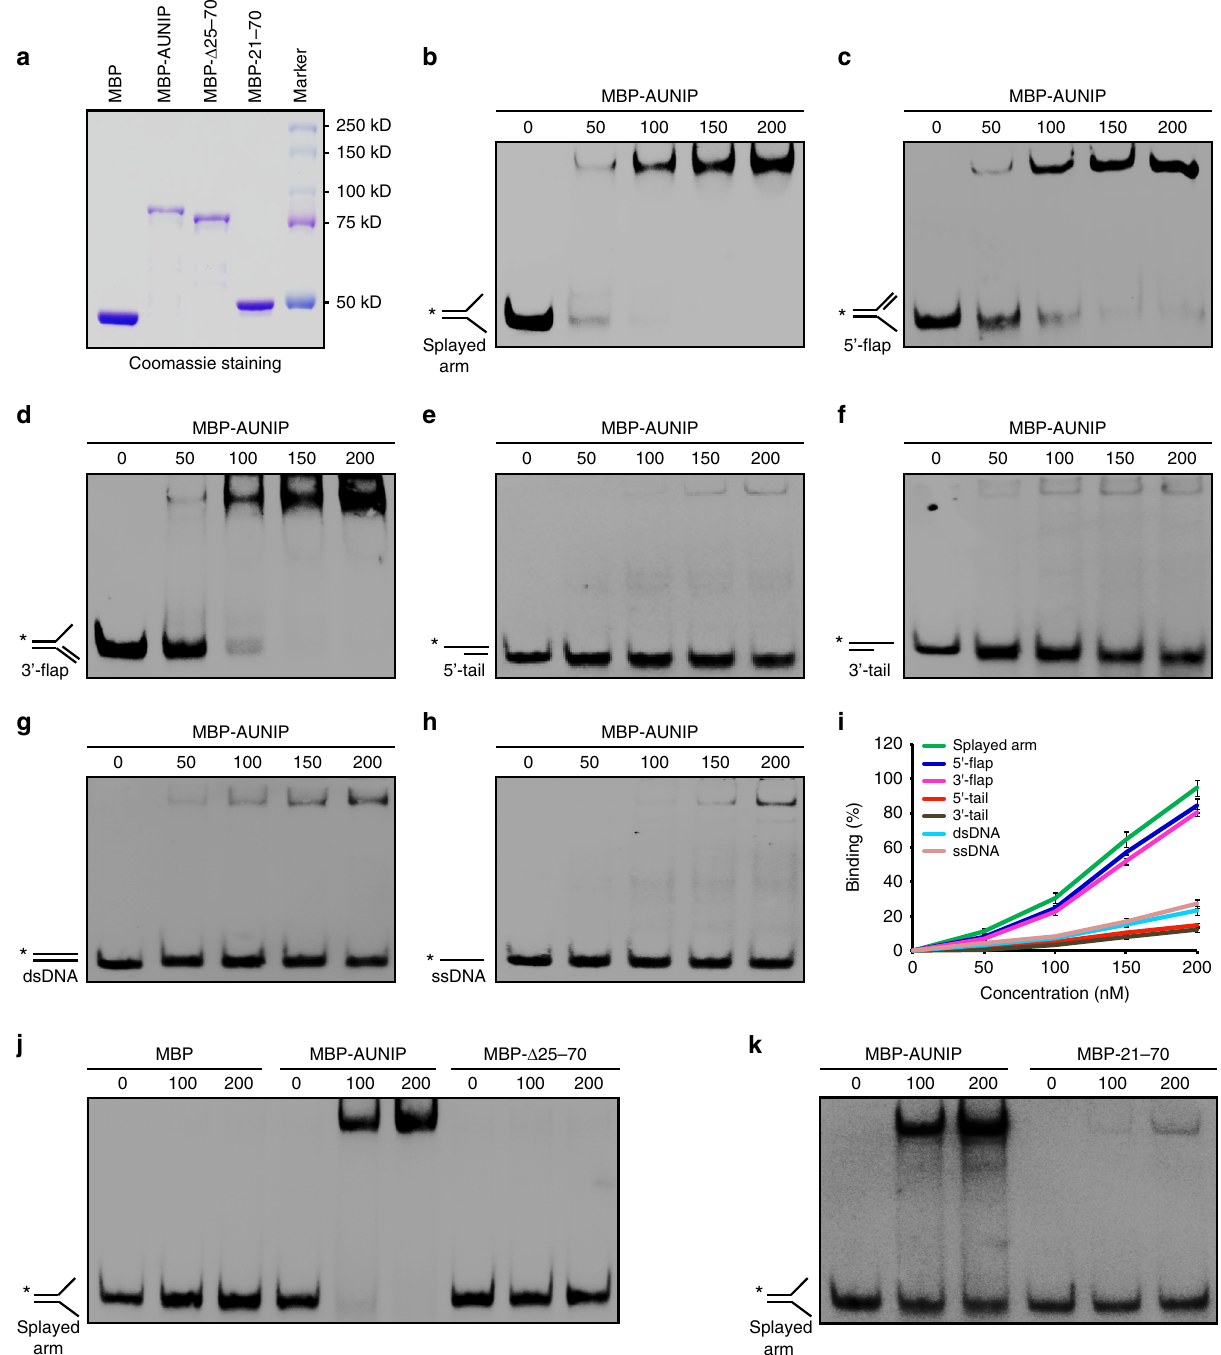
Fig. 6 DNA-binding activity of AUNIP. a SDS-PAGE pro fi le of puri fi ed MBP-tagged wild-type and mutants of AUNIP. b – h DNA-binding activity of AUNIP. Biotin-labeled DNA substrates (20 nM each) were incubated with increasing amounts of puri fi ed MBP-AUNIP (0, 50, 100, 150, 200 nM). i Quanti fi cation of the results is shown in b – h . Data were derived from three independent experiments and are presented as mean ± SEM. j The region encompassing amino acids 25 – 70 of AUNIP is required for its DNA-binding activity. Biotin-labeled DNA substrates (20 nM) were incubated with increasing amounts of puri fi ed MBP-tagged AUNIP or its mutant (0, 100, 200 nM). k The region encompassing amino acids 21 – 70 of AUNIP is suf fi cient for DNA binding. Biotin- labeled DNA substrates (20 nM) were incubated with increasing amounts of puri fi ed MBP-AUNIP or its mutant (0, 100, 200